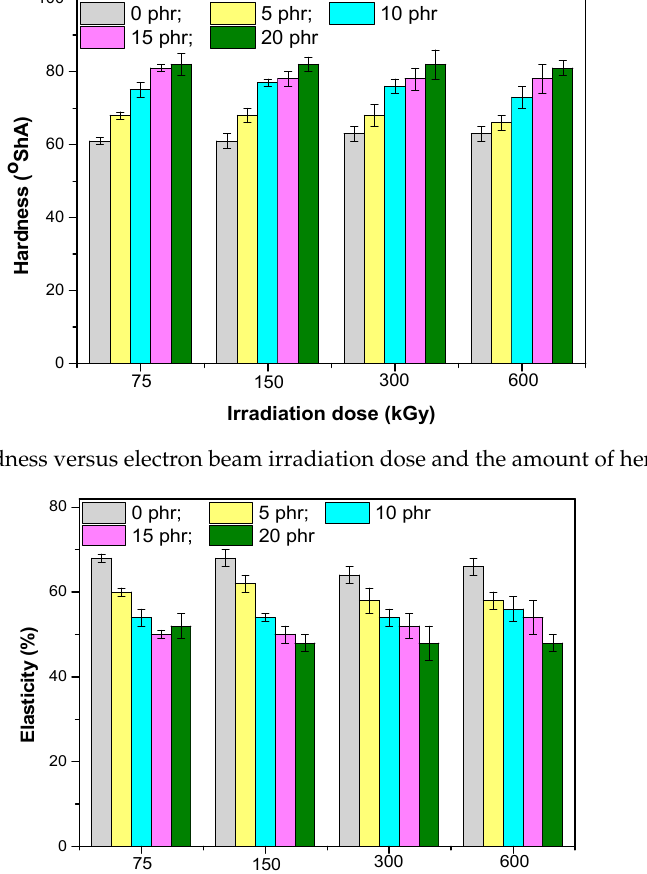
Figure 4. Residual elongation versus EB irradiation dose and the amount of hemp fibers.